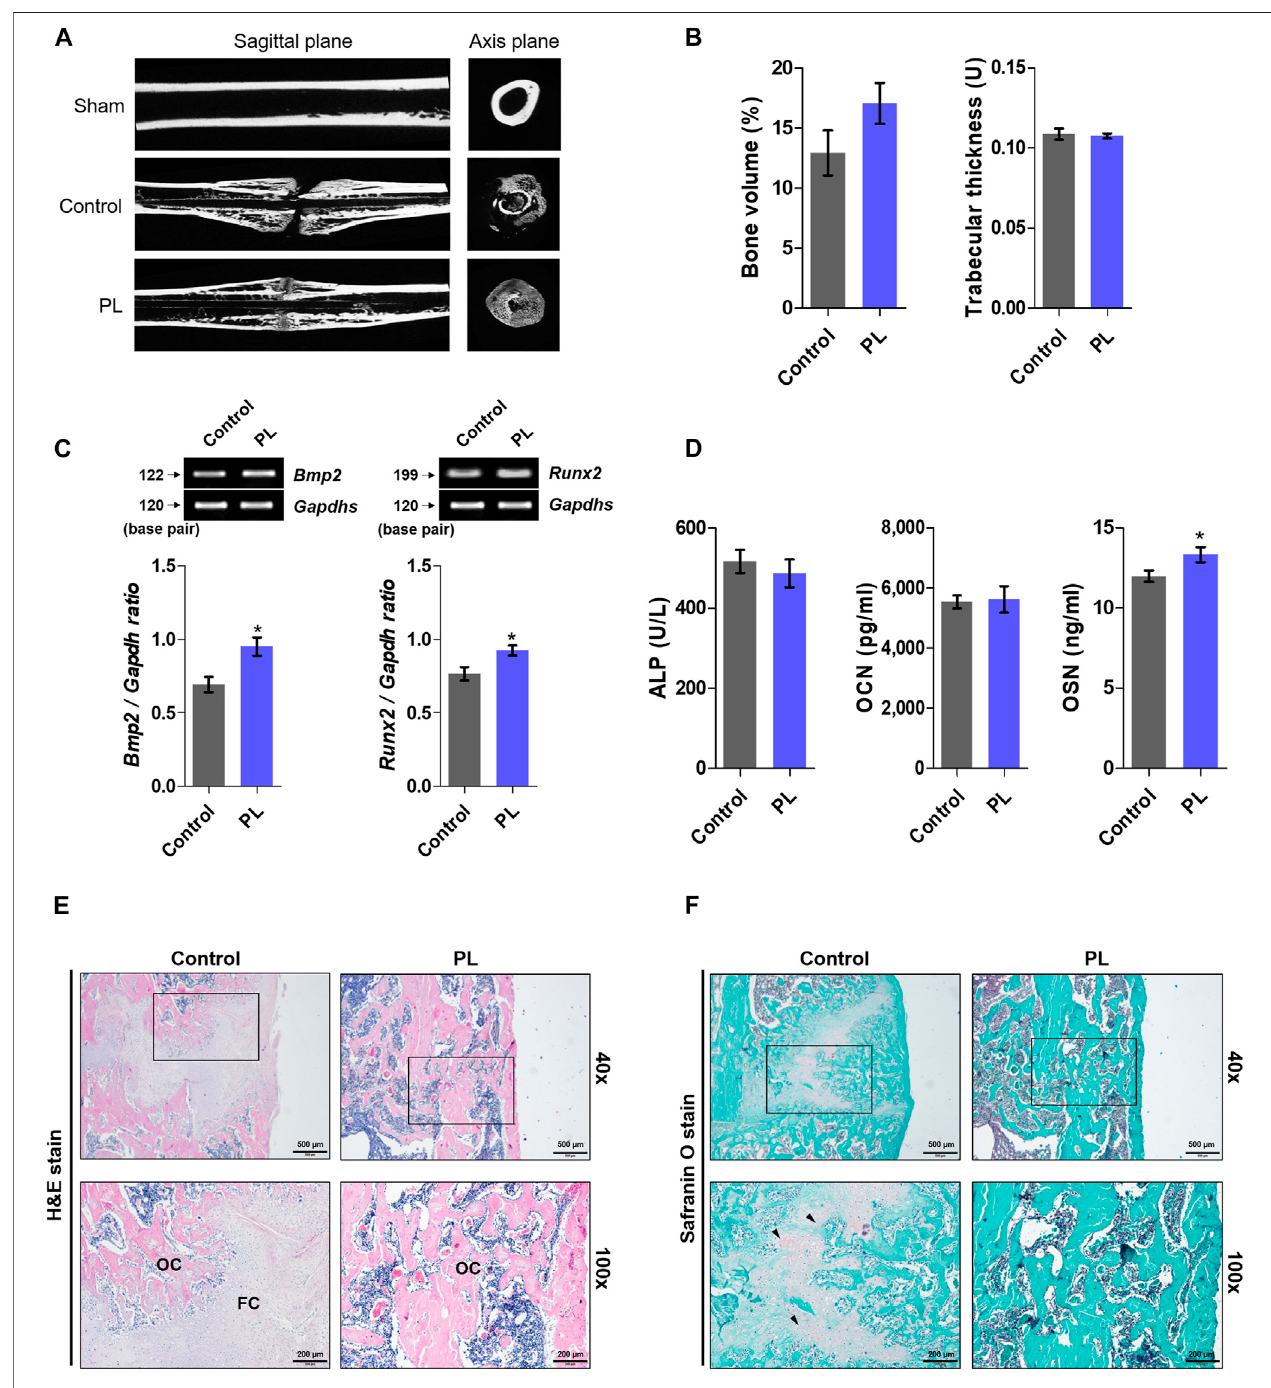
FIGURE3 | Effect ofPL on healingof ratfemoralfractures (A) Sagittal plane (upper panel) and axis plane (lower panel) micro-CTimage ofafracture-induced femur at5 weeks (B) Bonemicrostructurewasanalyzedbymicro-CT. (C) mRNAexpressionofosteogenicmarkerssuchasBMP-2andRUNX2wasmeasuredinwholeblood (D) The expression of ALP, OCN and OSN was measured in serum. Femoral tissue was embedded in paraf fi n, and histological analysis was performed. (E) Changes in fi brous and osseouscallus at thefracture site wereobserved byHand Estaining. The abbreviationsin theH and Estaining areas follows: OC, osseous callus; FC, fi brous callus (magni fi cation: × 40 and 100 × , scale bar: 500 and 200 µm) (F) Cartilage areas in the fractured sites were compared by safranin O staining (magni fi cation: × 40 and 100 × , scale bar: 500 and 200 µm). These results are presented as the mean ± SEM ( n (cid:2) 8 for each group). * p < 0.05 vs. control.